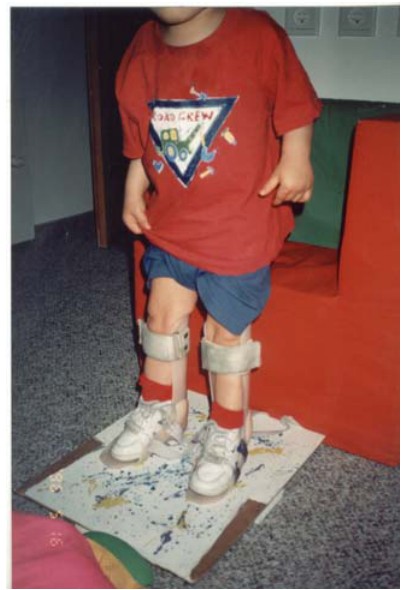
FIGURE 2. A "splint standing frame".